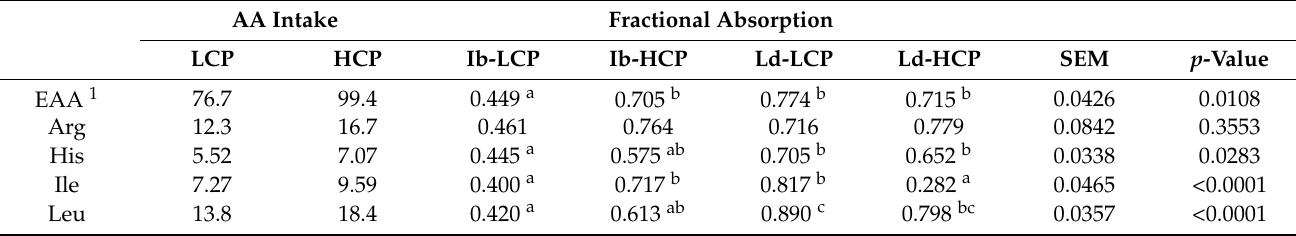
Table 3. Fractional absorption (NPA/AA intake; mmol) of EAA, NEAA and total AA in Iberian (Ib; n = 6) and Landrace (Ld; n = 6) pigs receiving either LCP (145 g CP/kg DM) or HCP (187 g CP/kg DM)